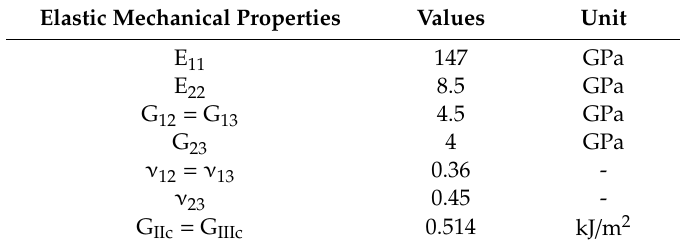
Table 1. Elastic mechanical properties of the investigated material systems.